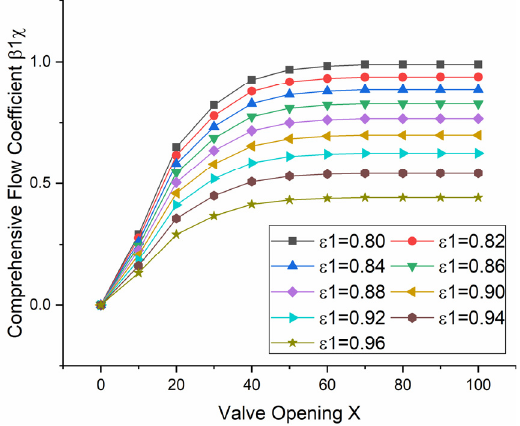
Energies 2022 , 15 , x FOR PEER REVIEW Figure 4. Comprehensive flow coefficient curve of governing valve. Figure 4. Comprehensive flow coefficient curve of governing valve.